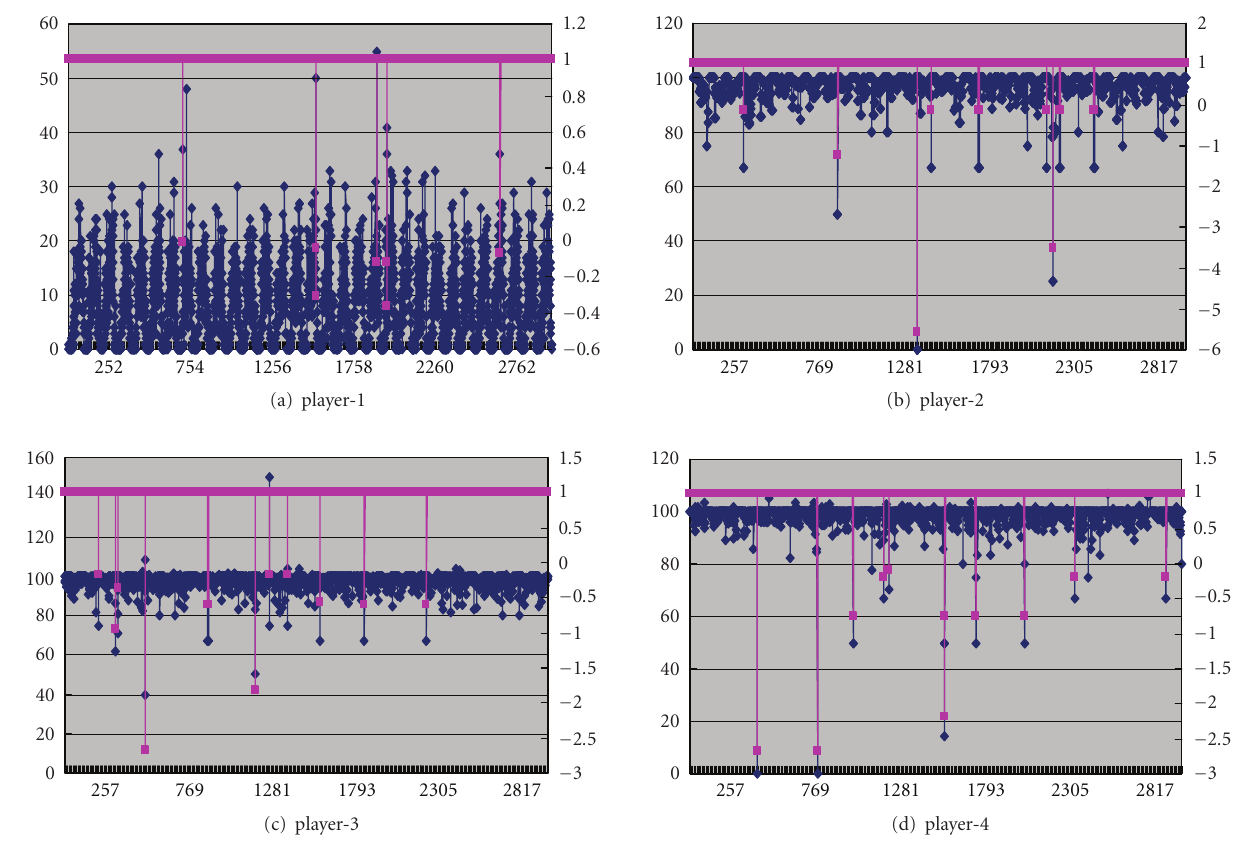
Figure 3: Summary illustration of experimental